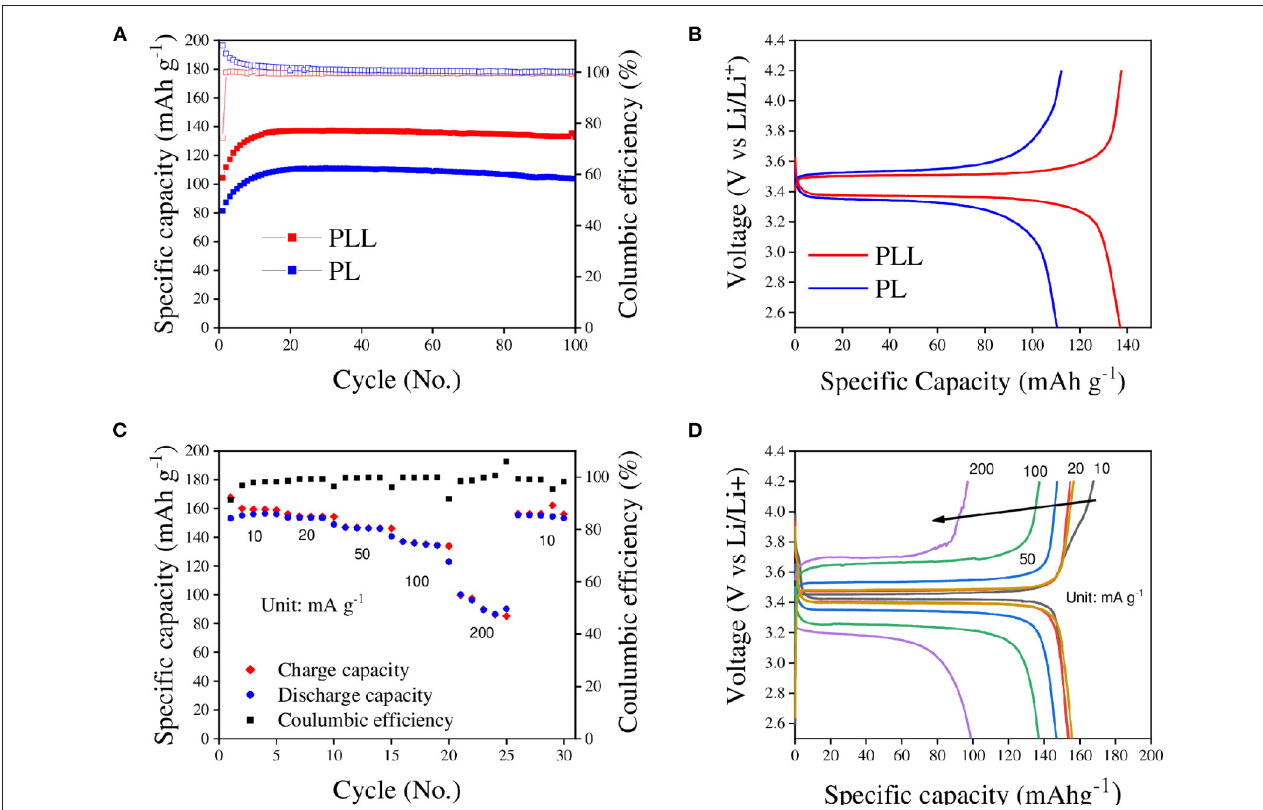
FIGURE 5 | (A) Long cycle performances of the PLL and PL electrolytes in full-cell tests (LiFePO 4 /PLL/Li and LiFePO 4 /PL/Li) at 50mA g − 1 current density and 60 ◦ C for 100 cycles. (B) Galvanostatic charge-discharge profiles of the batteries with the PLL and PL electrolytes at the 25th cycle derived from (A) . (C) Rate capability of the battery with the PLL electrolyte with the current density ranging from 10 to 200mA g − 1 . (D) Galvanostatic charge-discharge profiles of the battery with the PLL electrolytes for the rate capability test at the first cycle of each current density derived from (C) .